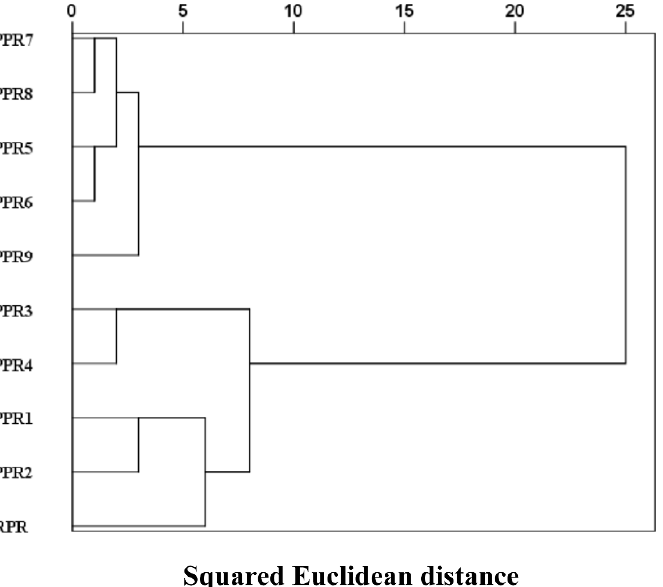
Figure 10. Dendrograms of HCA with a dataset including pH, E–nose, E–tongue, and GC-MS data.